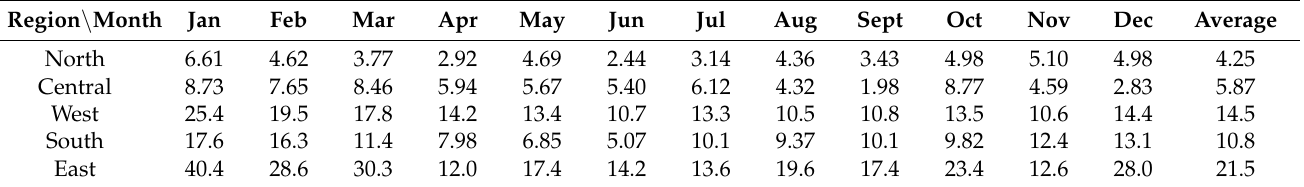
Table 2. Prevalence rate of diarrhea cases (per 100,000) by month in regions of